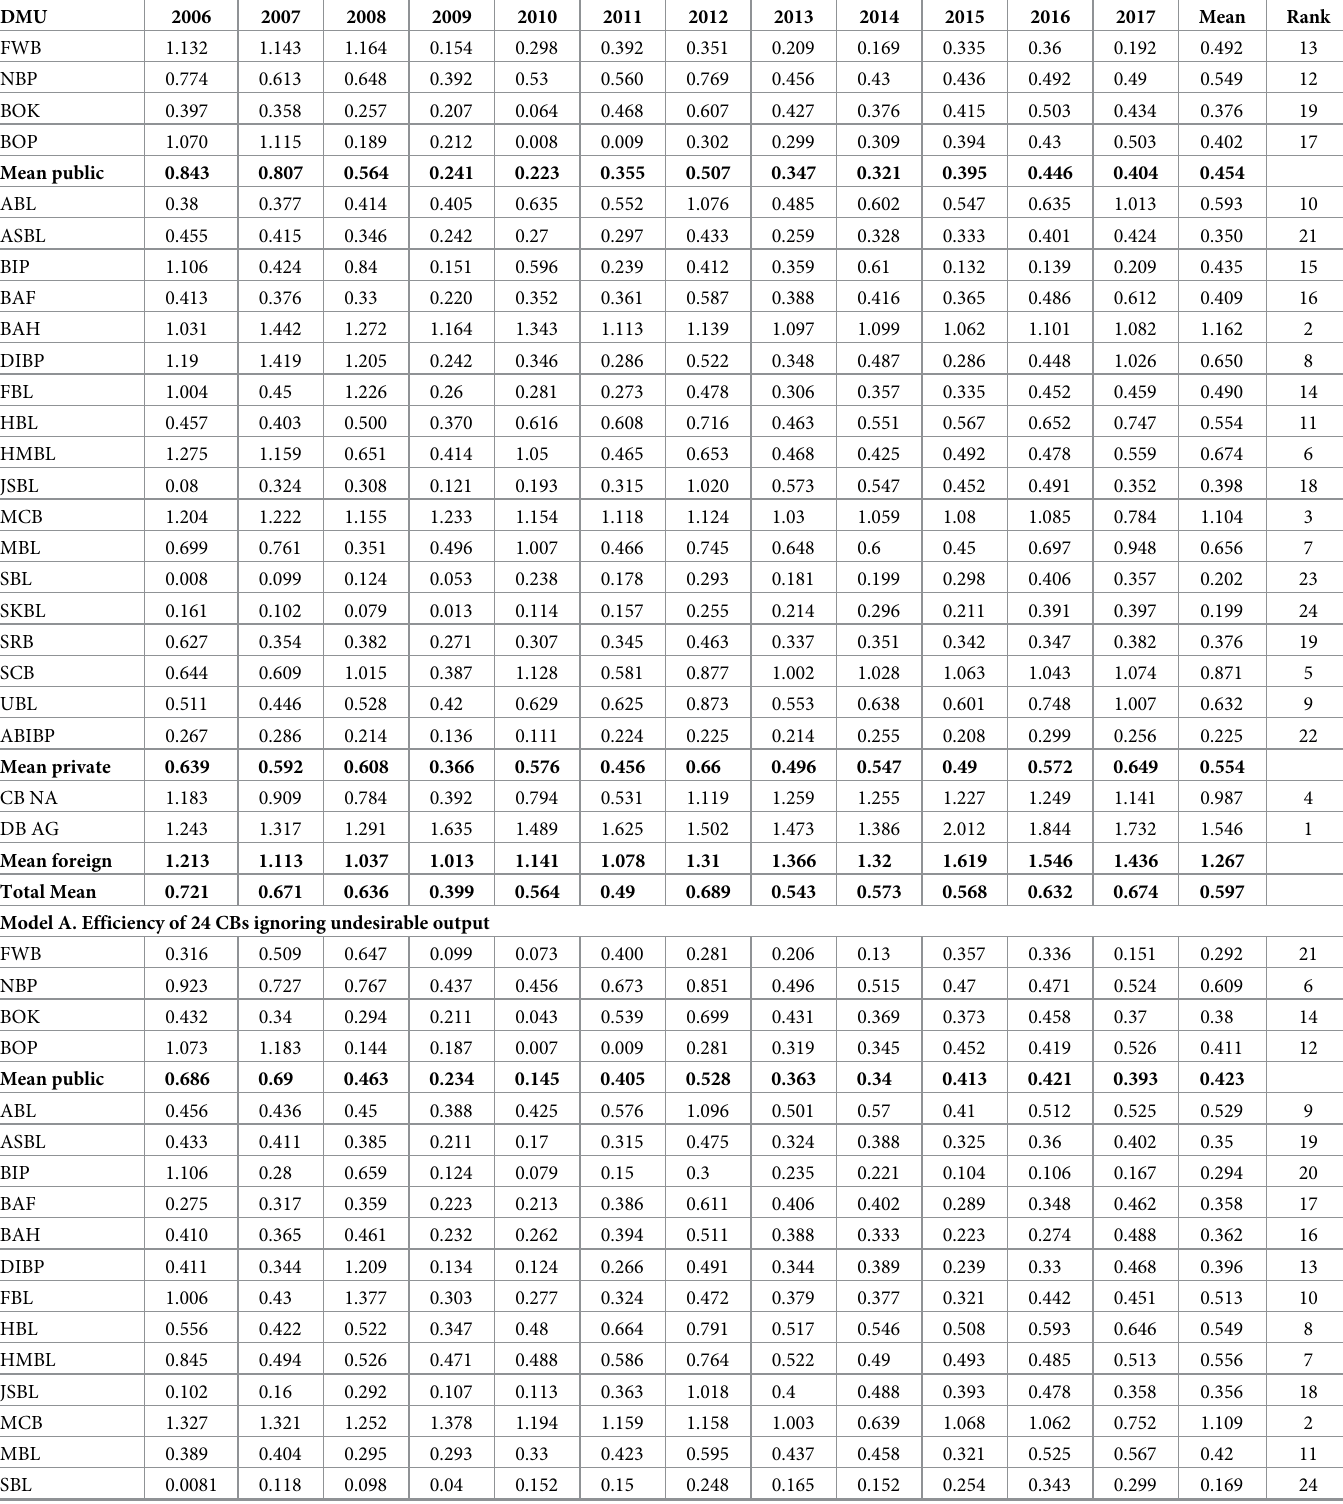
Table 4. Model A. Efficiency of 24 CBs Considering the undesirable output. DMU